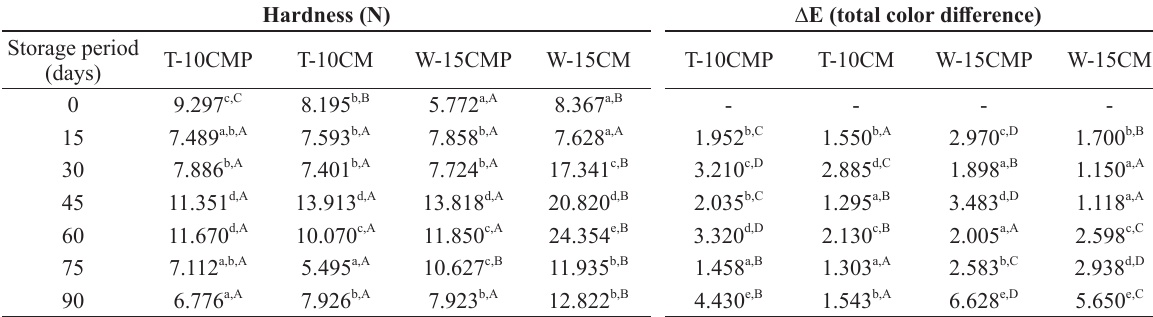
Hardness and total color difference of the